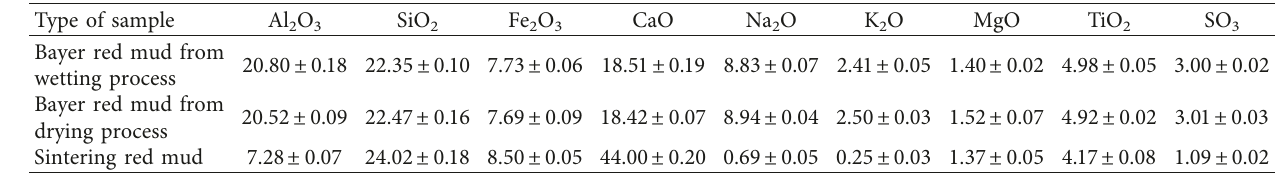
Table 2: Chemical composition of the three kinds of red mud